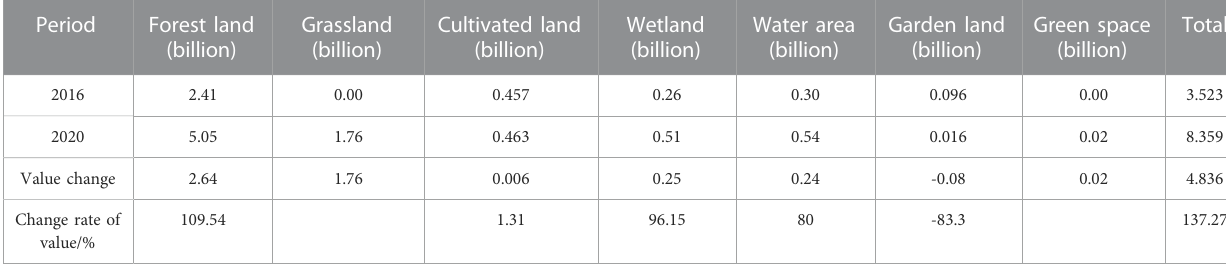
TABLE 6 Changes of land use value of the study area in